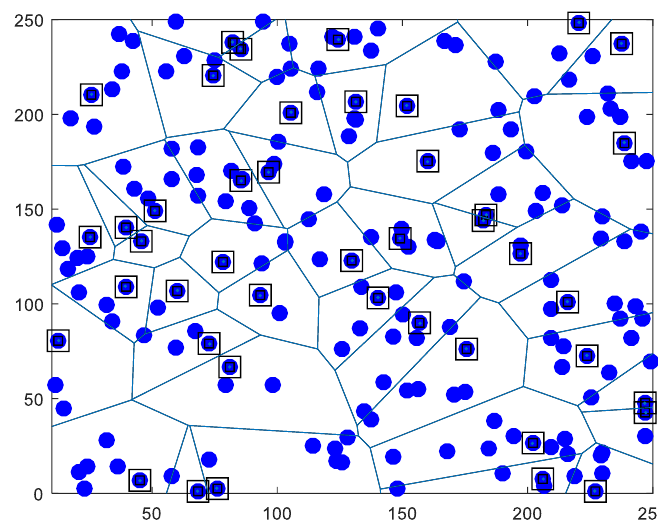
Figure 3. An illustration of the clustered heterogeneous network model in our proposal scheme.